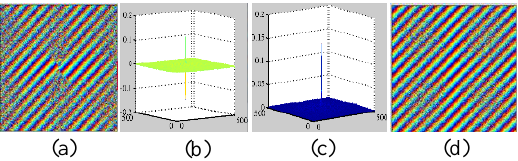
Figure 4. AD-SVD algorithm for azimuth angle variation. (a) PC fringes between images of different azimuth angles. (b) Dirichlet function derived from IFT of (a). (c) The absolute value of the Dirichlet function in (b). (d) The power spectrum fringes of the FT of (c). As indicated in section 3.3, the impact of zenith